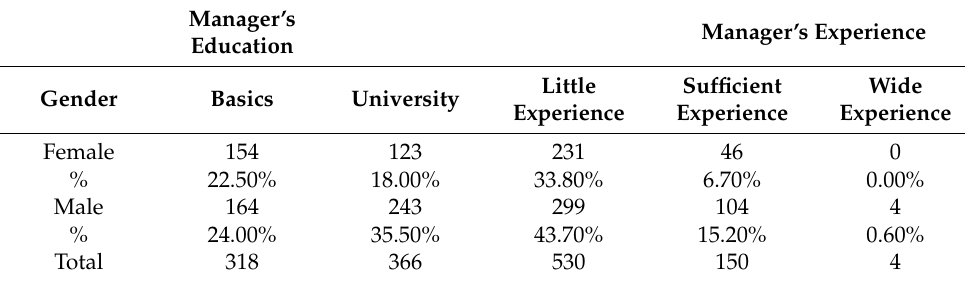
Table 3. Manager’s gender, level of education, and